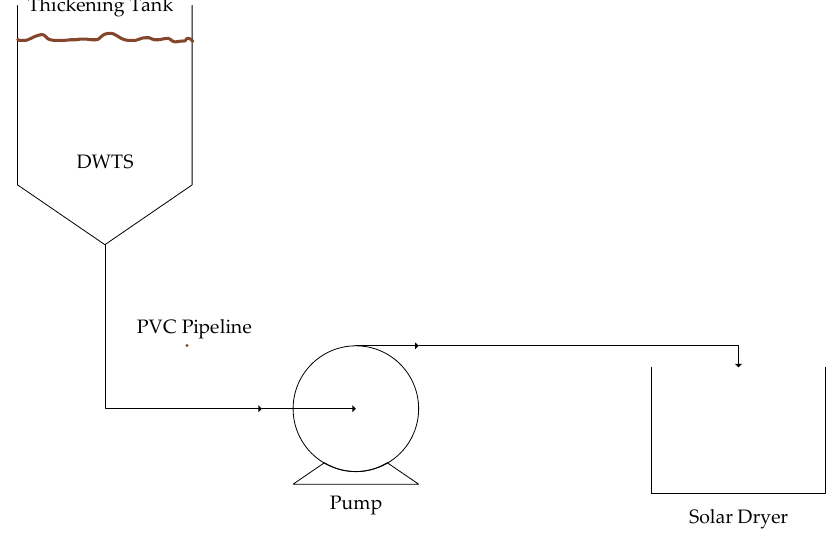
Figure 7. Schematic diagram of the assembly line.